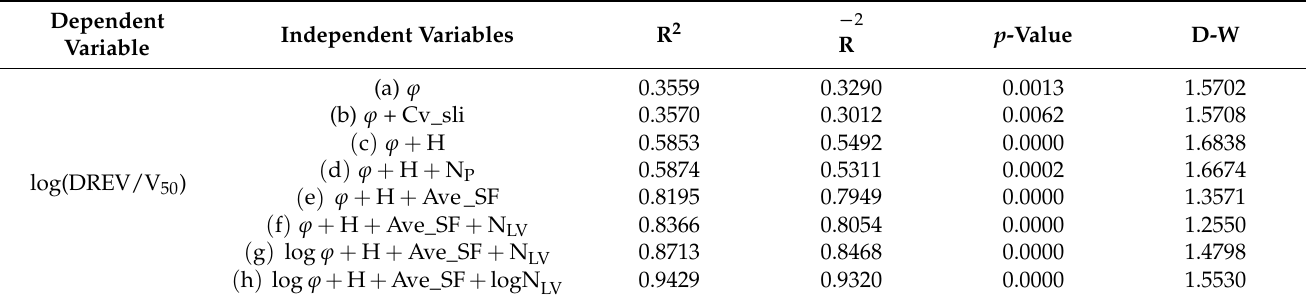
Table 2. Adjusted Coefficient of Determination between Determined and Estimated